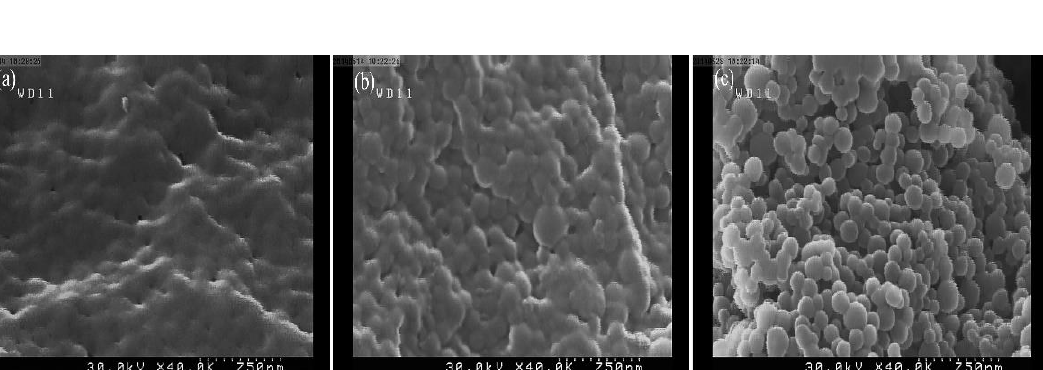
Fig. 2. FE-SEM micrographs of gelatin nanoparticles with different amounts of cross-linker agent added, 16 µl (a); 17 µl (b) and 20 µl (c)